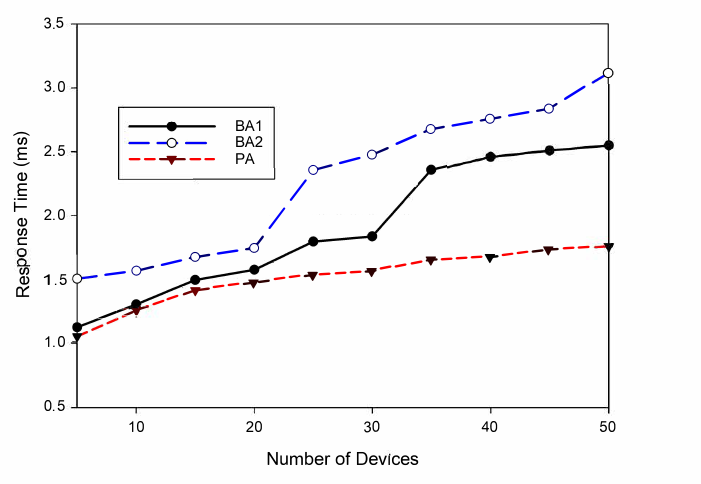
Figure 6. Proposed approach’s response time compared to the baseline